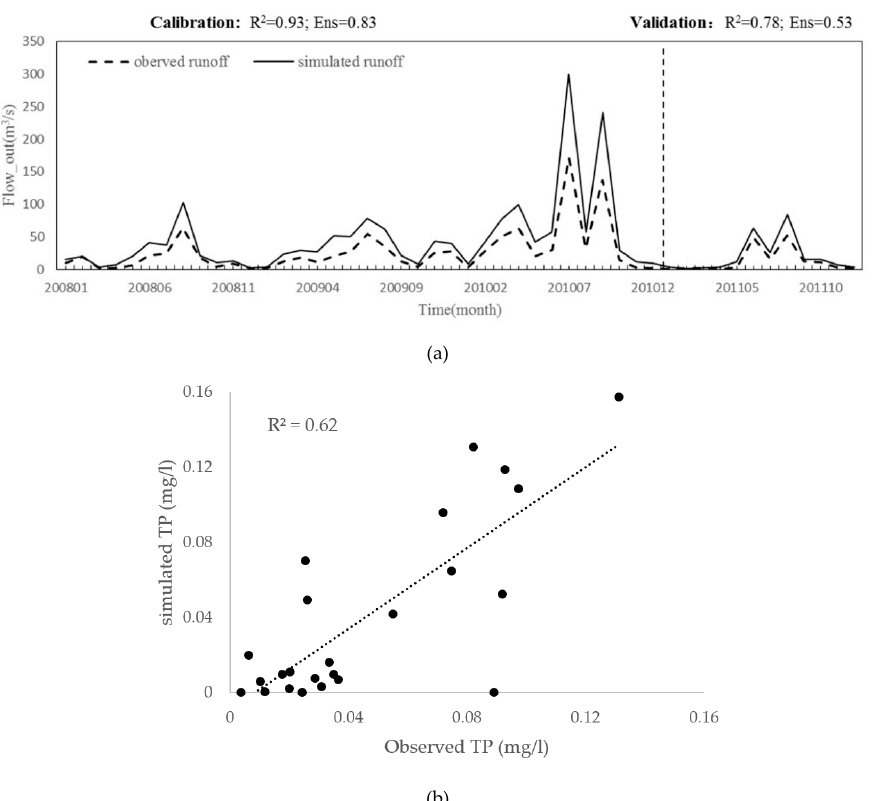
Figure 3. River flow correction and verification results and verification of water quality simulation (a: River flow correction and verification, b: verification of water quality simulation).